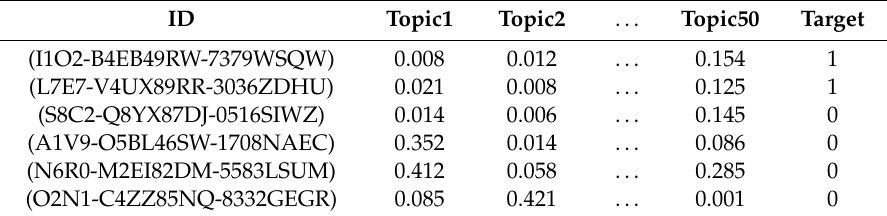
Table 7. Quantified e-mail content examples with actual label (normal = 0 and abnormal = 1). ID